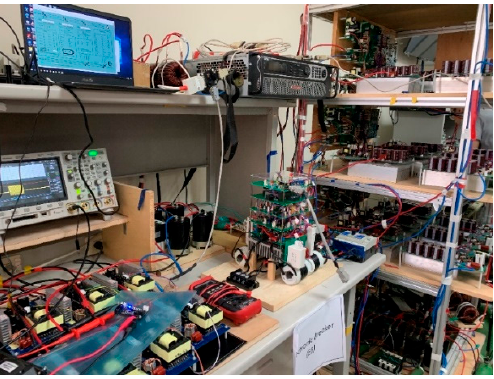
Figure 22. The photograph of the proposed PV micro-grid prototype system with communication scan